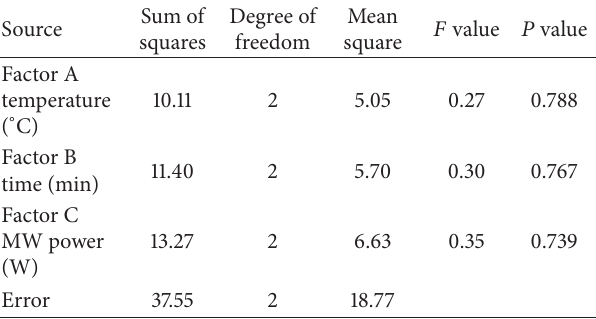
Table 3: Variance analysis of orthogonal experiments on synthesis of 2-methyl-4-(3,4-acetoxybenzylene)oxazol-5-ones.